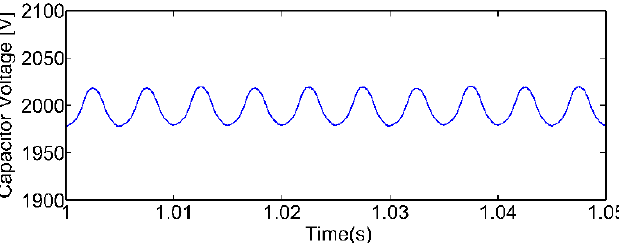
Figure 8. The upper arm and lower arm capacitor voltages of the proposed DC-DC MMC when r = 0.5.